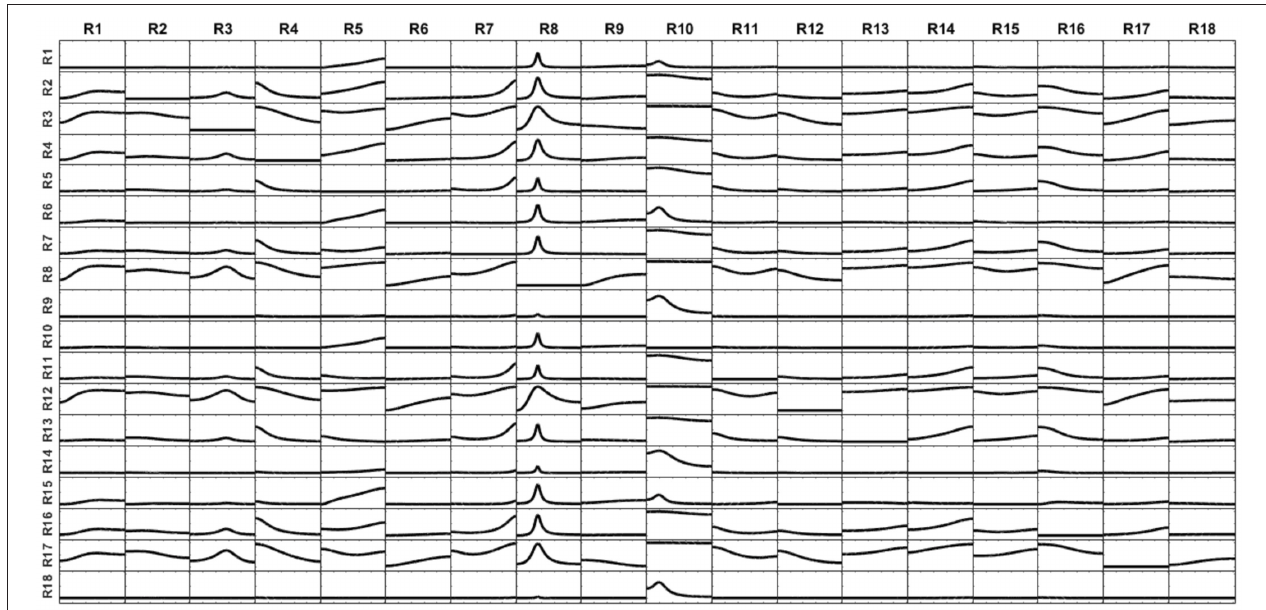
FIGURE 15 | iCoh patterns of connectivity obtained from reconstructed currents at the cortex surface by using the superficial lead field when the voltage was generated by sources lying in the inner layer, bellow but close to the surface. The big effect of mixing in distorting the real connectivity pattern is because of the superficial lead field does not regard the voxels in the inner layer, hence surface-based unmixing lacks relevant information on inner voxels to successfully unmixed the superficial sLoreta source